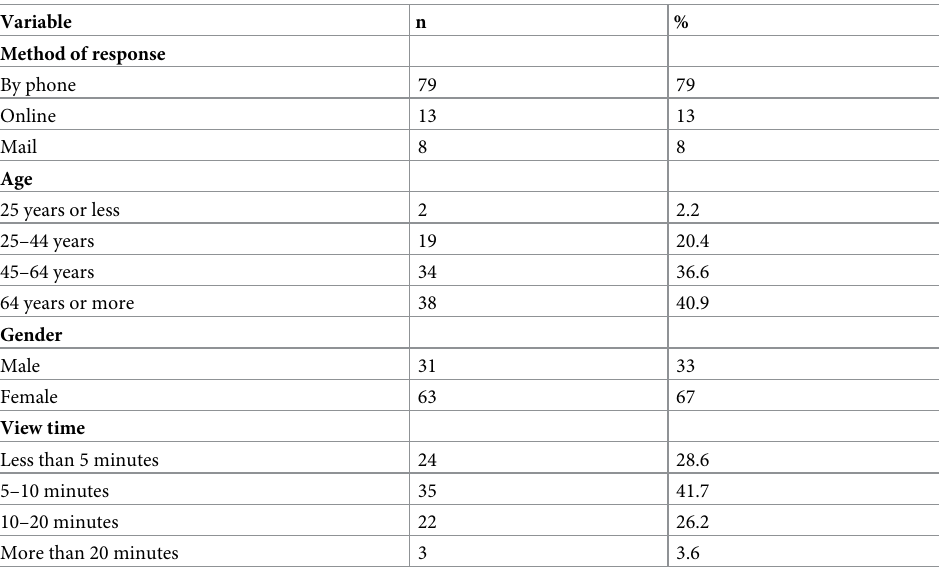
Table 3. Participant demographics (n = 100) at